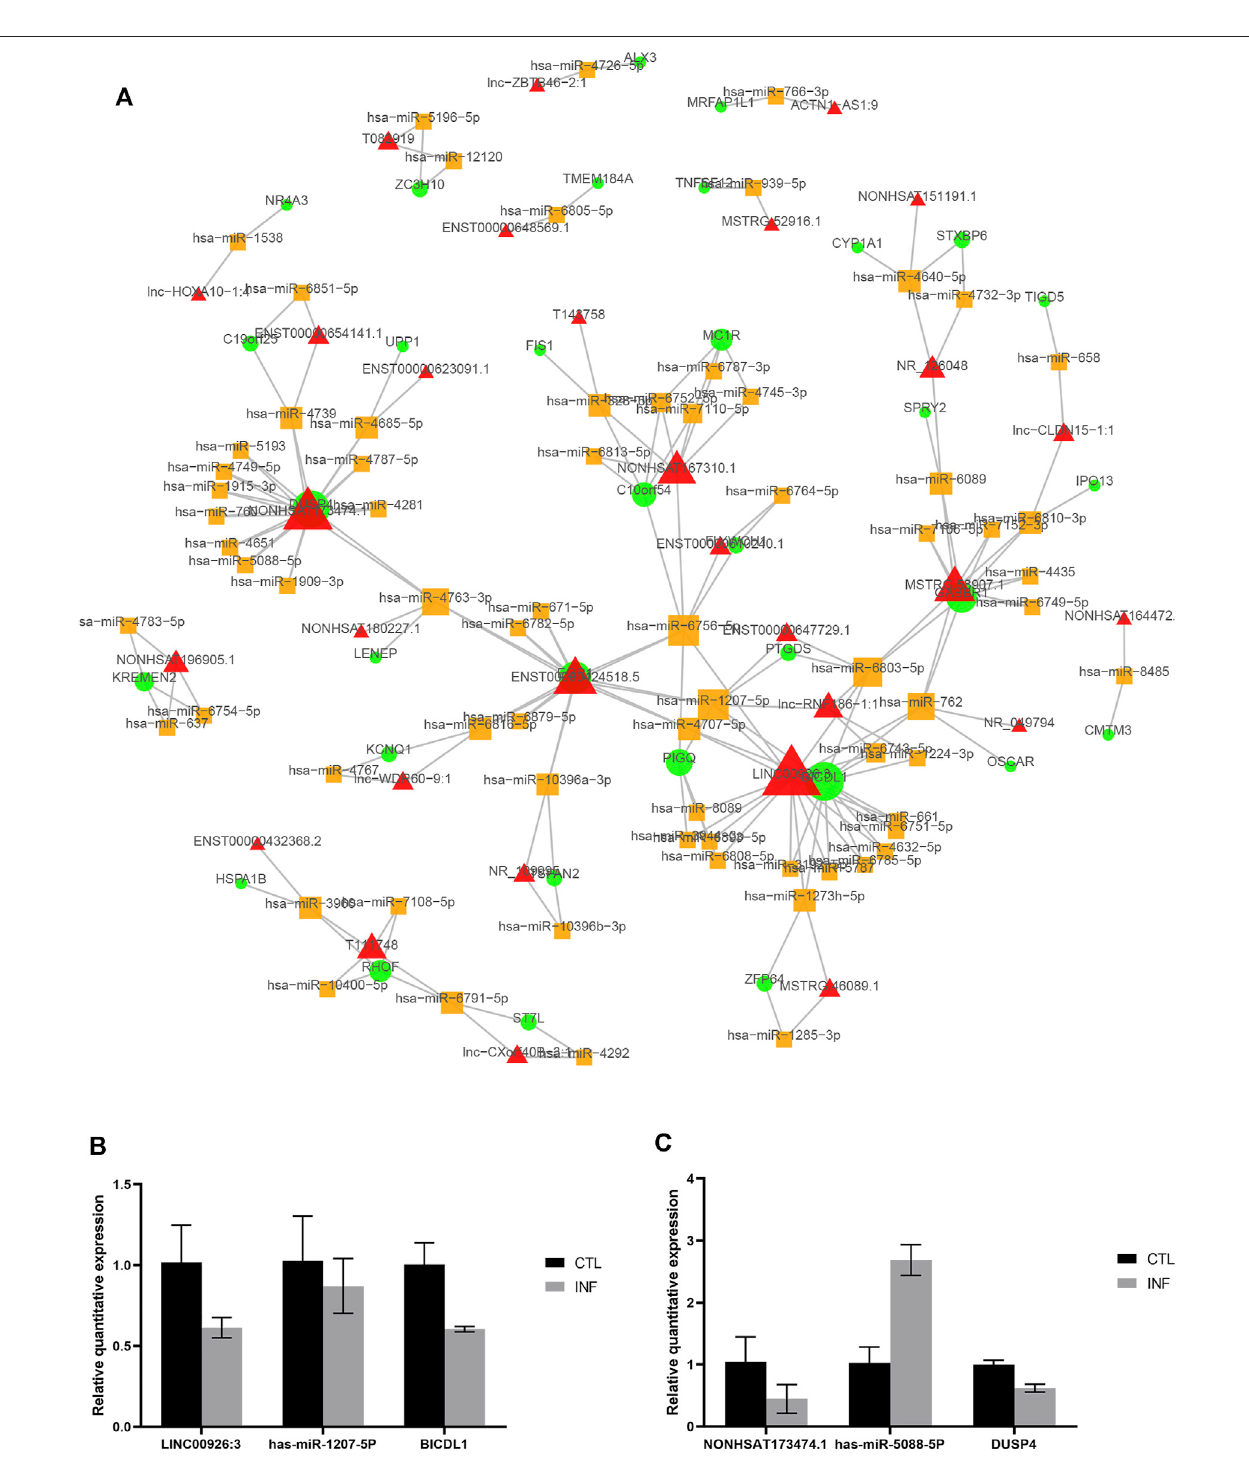
FIGURE 7 | CeRNA network in the persistent chlamydial infection. (A) The top 100 lncRNA-miRNA-mRNA competing endogenous RNA (ceRNA) network. The triangle node represents lncRNA , the circular node represents mRNA, and the square node represents miRNA. The node size proportional to the number of connected nodes. (B,C) Quantitative real-time PCR results of ceRNA.